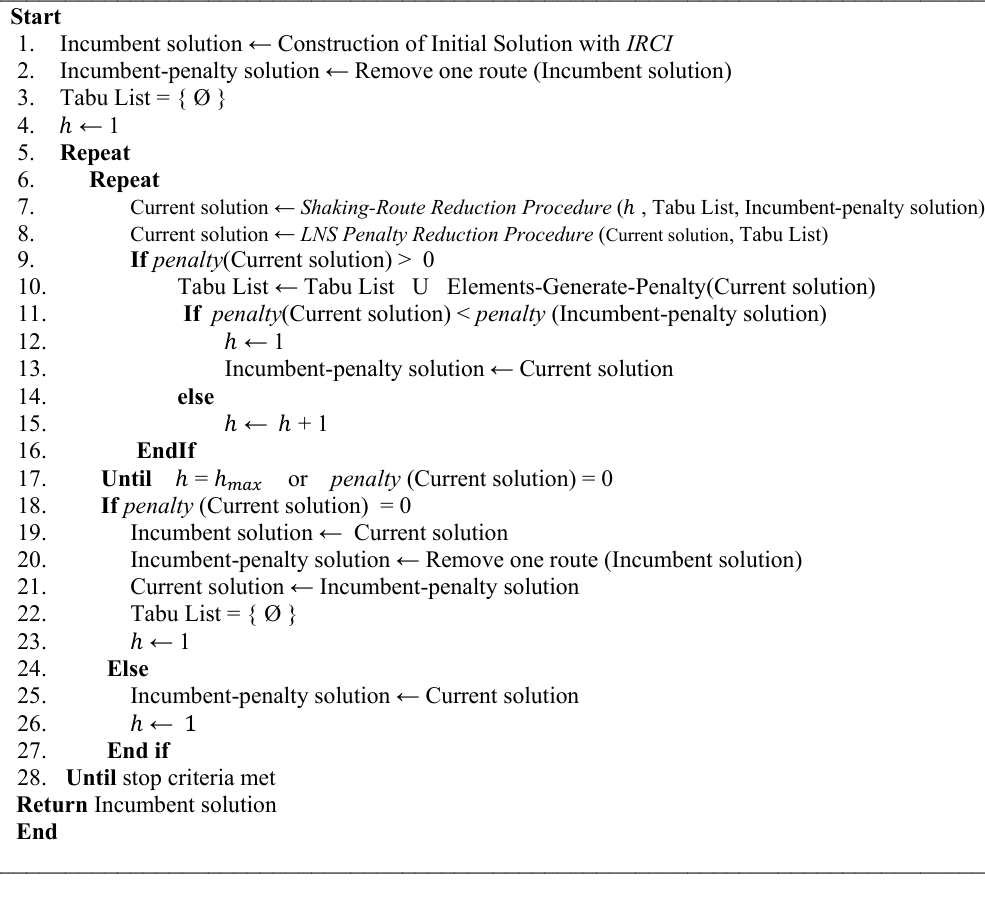
Algorithm 2: Number of vehicles minimisation